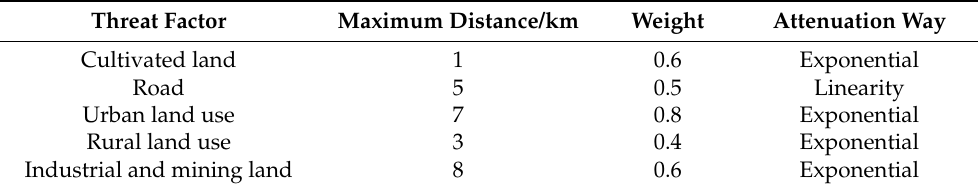
Table 4. Threat factor properties.